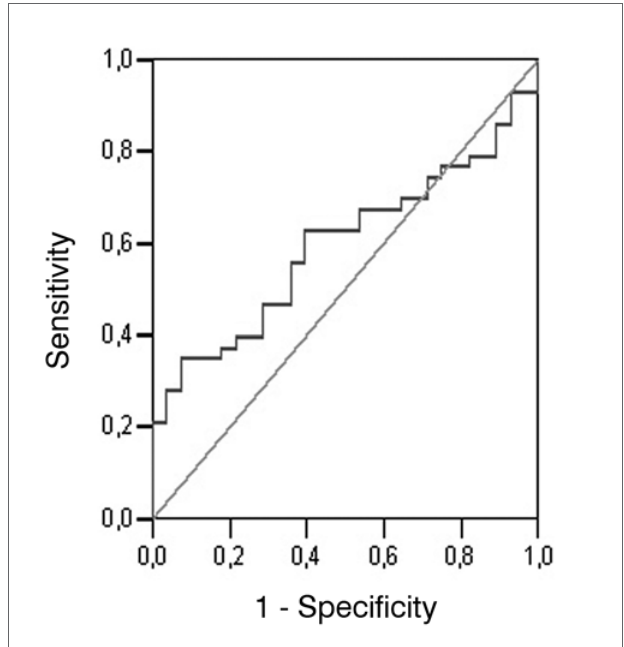
Figure 3. Graphic representation (ROC curve) of the plotting of numerous sensitivity and specificity points of the angular measure considering GC and GDM.